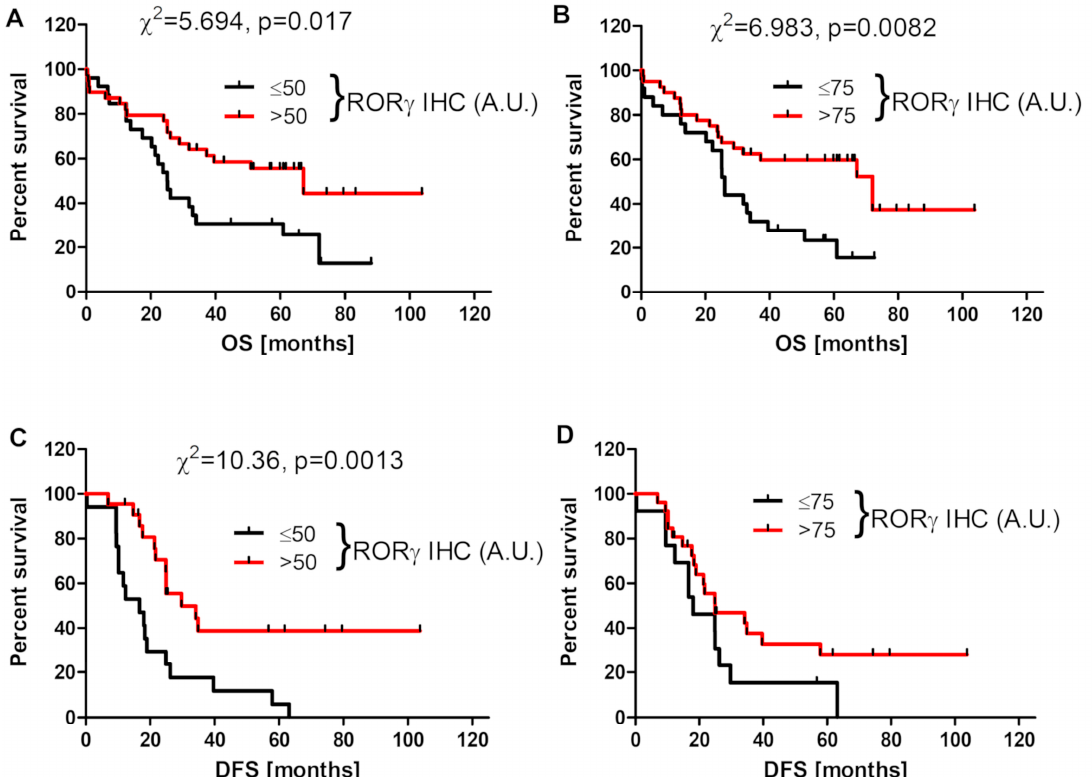
Figure 3. Overall survival (OS) ( A , B ) and disease-free survival (DFS) ( C , D ) of ovarian cancer patients in relation to cytoplasmic ( A , C ) and nuclear ( B , D ) ROR γ immunostaining ( n =